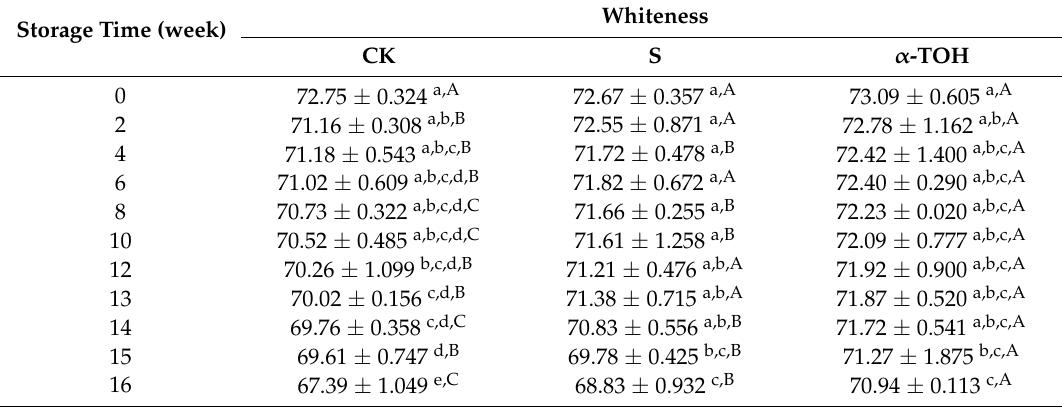
Table 2. Effect of α -TOH on the whiteness of sturgeon surimi during frozen storage at − 18 ◦ C for 16